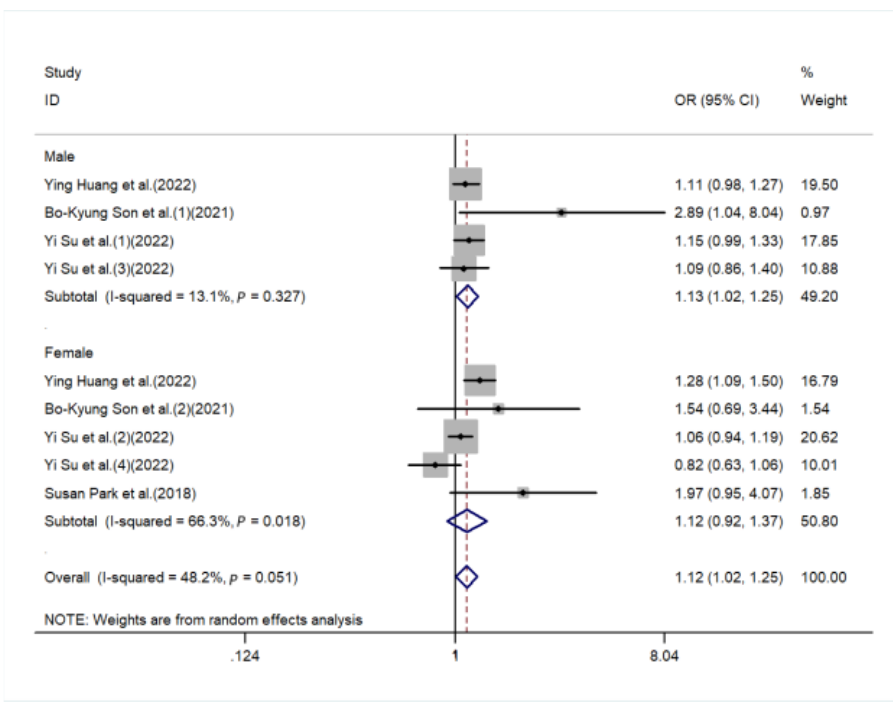
Figure 3. Forest plot for the subgroup of sex [20,24,26-28] .